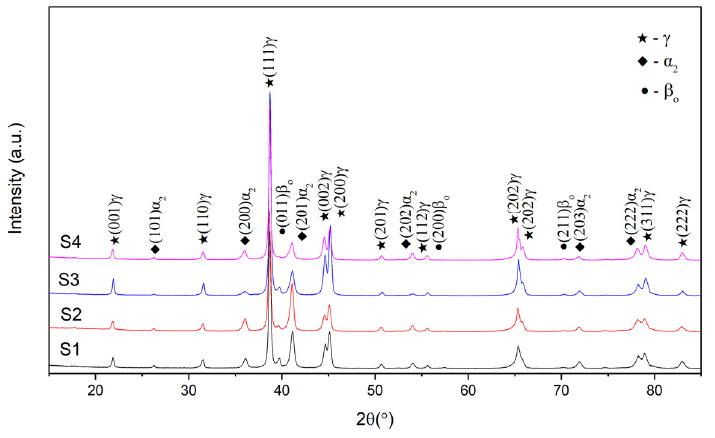
Figure 1. X-ray diffraction (XRD) patterns of ingots with different compositions.